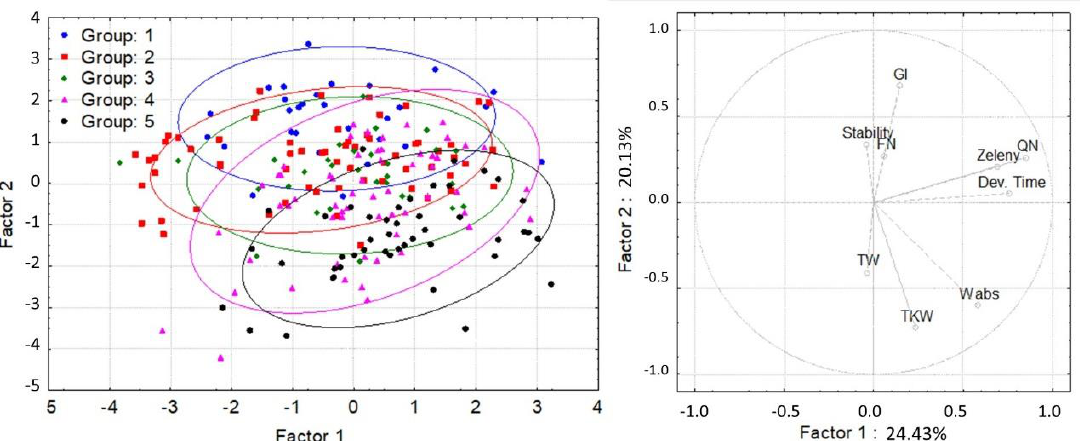
Figure 5. Principal component analysis based on the breadmaking quality traits of wheat and grouped by the groups formed by the hierarchical cluster analysis. Dev Time = dough development time, FN = falling number, GI = gluten index, QN = farinograph quality number, Stability = dough stability time, Zeleny = Zeleny sedimentation volume, TKW = thousand-kernel weight, TW = test weight, and Wabs = water absorption (where the most determinant traits contributing to Factor 1 were Zeleny (0.6913), Dev Time (0.7594), and QN (0.8517), while they were GI (0.6779), Wabs ( −0 .5973), and TKW ( −0 .7269) for Factor 2). Table 3. Differences among the means of the five groups of the lines, determined by the hierarchical cluster analysis and evaluated by Tukey test.